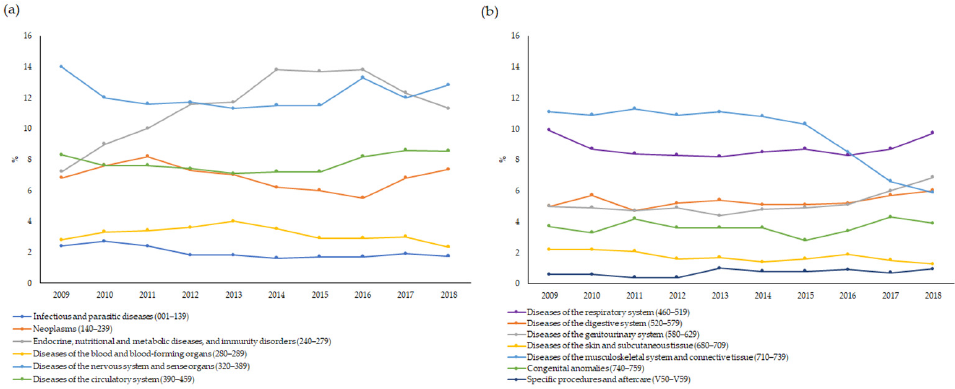
Figure 5. ( a , b ) Time trend of main causes of hospitalisation by ICD-9-CM